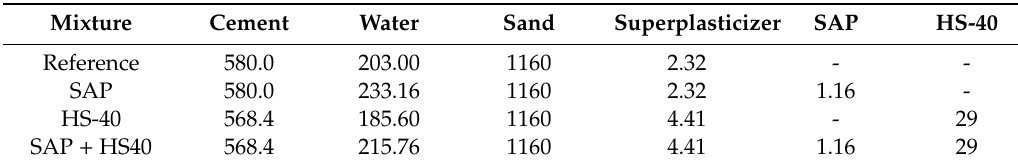
Table 1. Mixture proportions of mortar mixtures (kg · m − 3 ).